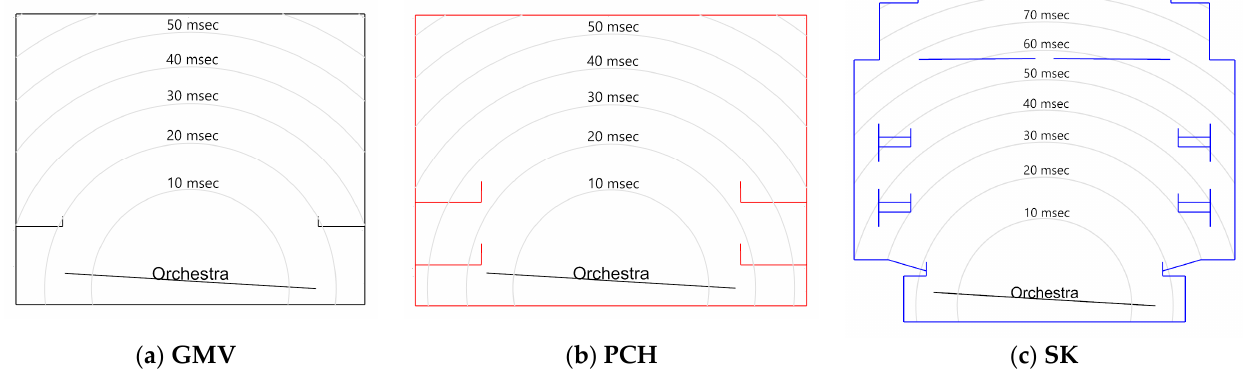
Figure 4. Potential Masking diagram for three concert halls: ( Black ) Große Musikvereinssaal, ( Red ) Perth Concert Hall, ( Blue ) Stavanger Konserthuset.